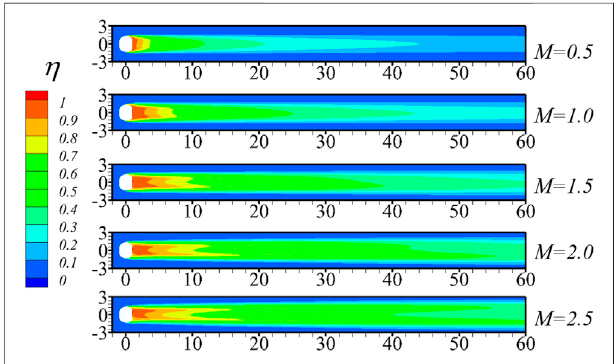
FIGURE 4 | Spanwise average ef fi ciency in C/L (cid:2) 0.5 case.